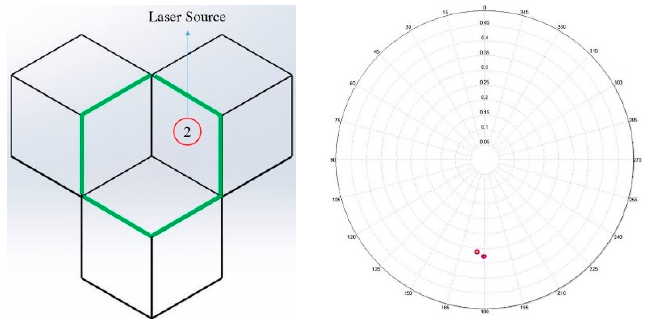
Figure 11. The CCCR #2 reflecting surface in the posterior region is hit by a simulated laser beam ( left ) and the resulting retro-reflected light intensity distributions ( right ).